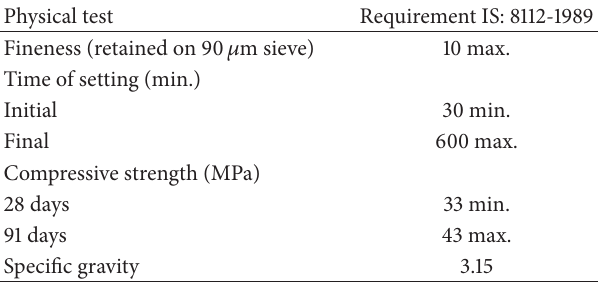
Table 1: Physical properties of Portland